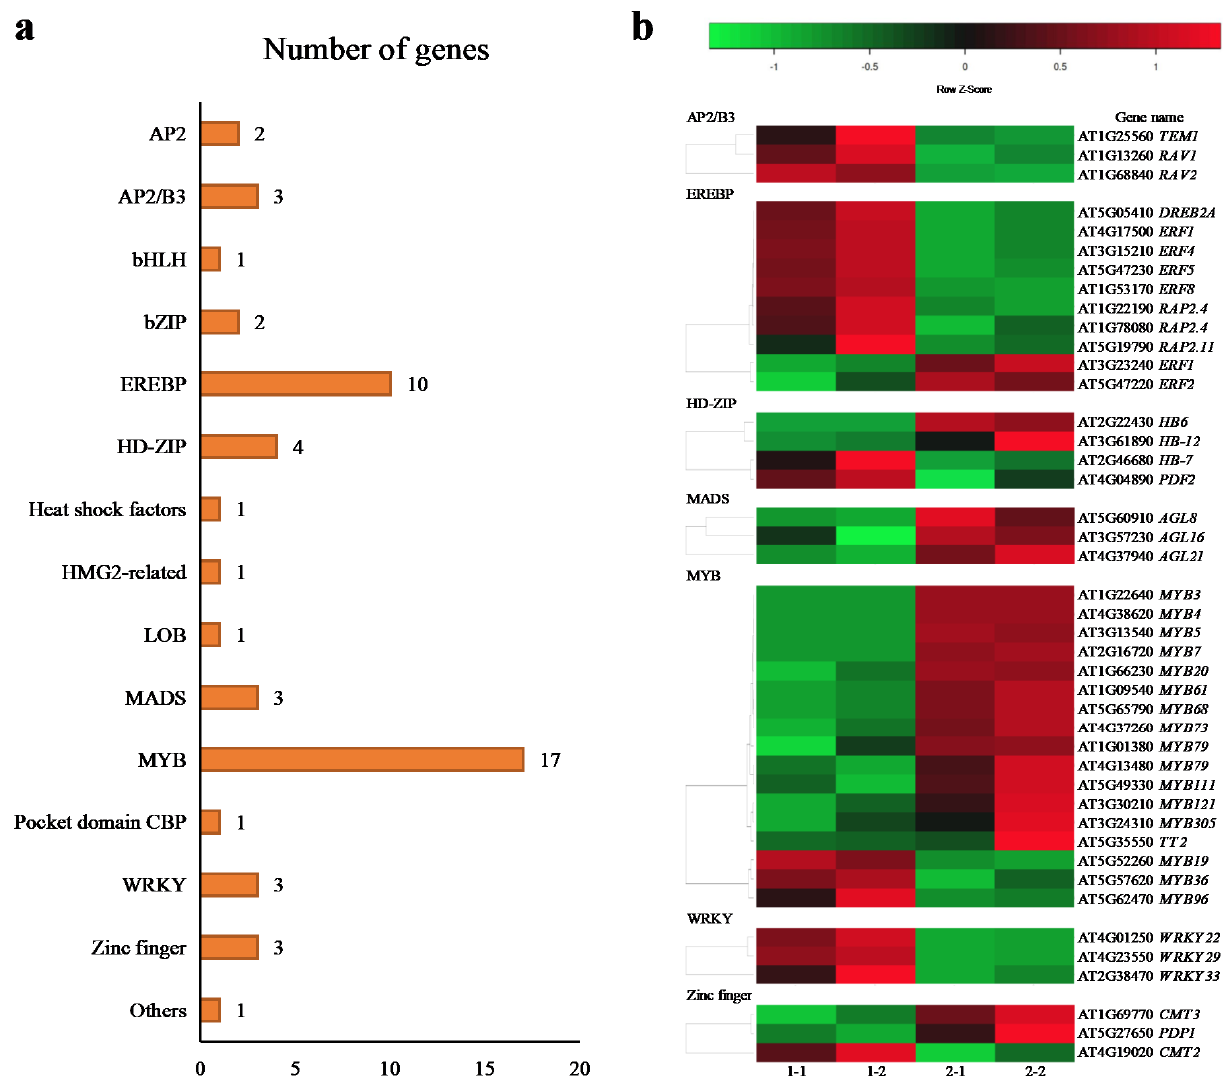
Figure 4. Transcriptional factors of DEGs identified in toluene untreated and treated A. pusilla . ( a ) The present study identified 53 TFs that were classified into 14 transcription factor families; ( b ) heat maps of various types TFs in toluene untreated (1-1, 1-2) and treated (2-1, 2-2) A. pusilla . Heatmap color represents the expression level of each gene (rows) in different treatments. (fold-change > 2, p -value < 0.05). Red bars: upregulation; green bars: downregulation.